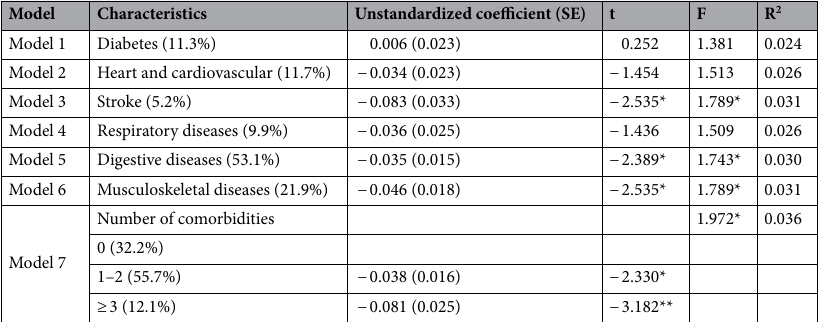
Table 2. Associations between comorbid chronic diseases and stigma in BCSs. SE, standard error. * p < 0.05; ** p < 0.01. In all these models, the dependent variable stigma was inverted transformed. And the following confounding factors were considered in each model: age, BMI and time since diagnosis as continuous variables, marital status, surgery, radiotherapy, chemotherapy, endocrine drug therapy, hysterectomy, recurrence and metastasis as dichotomous variables, education level and household per capital income as multi-categorical variables were converted into dummy variables before being included in the regression models. In model 7, the independent variable number of comorbidities was also converted into dummy variable (set dummy variables c1, c2; when number of comorbidities = 0, c1 = 0 and c2 = 0; when number of comorbidities = 1–2, c1 = 1 and c2 = 0; when number of comorbidities ≥ 3, c1 = 0 and c2 = 1). In all these models, all the variation inflation factor (VIF) values were below